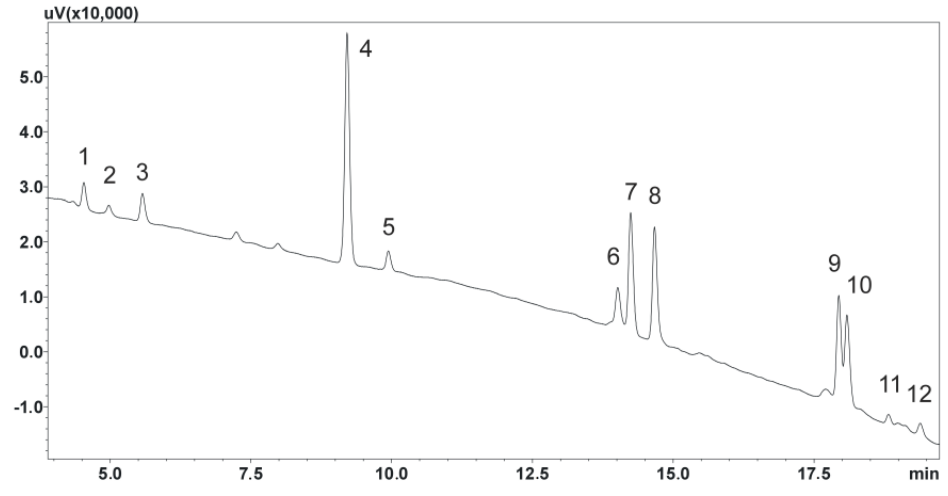
Figure 2. Chromatogram of the standard solutions obtained by optimized UHPLC. (1) N–desmethylmirtazapine; (2) O–desmethylvenlafaxine; (3) mirtazapine; (4) chlordiazepoxide, IS; (5) venlafaxine; (6) mianserin; (7) N–desmethylcitalopram; (8) citalopram; (9) duloxetine; (10) amitriptyline; (11) N–desmethylsertraline; (12) sertraline.